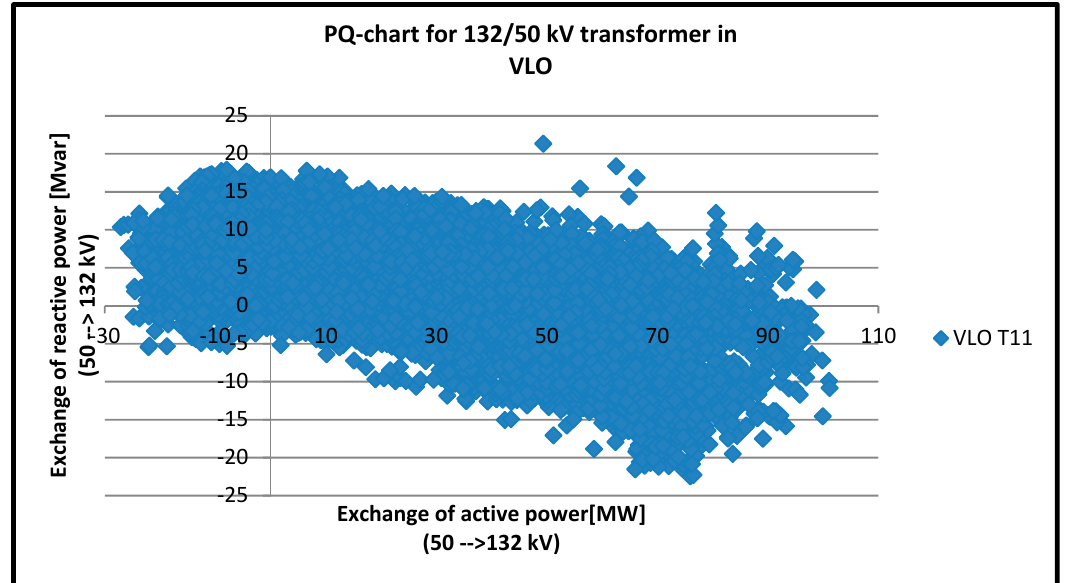
Figure 2. Scatter plot of 132/50 kV at substation VLO. Positive sign convention indicates the flow direction from the distribution side, to the transmission side.